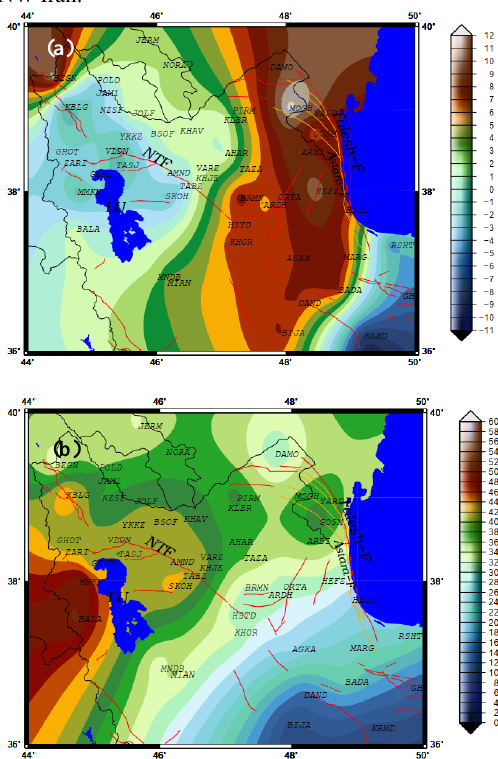
Figure 5. (a) surface dilatation rate. (b) Surface maximum-shear rates in the NW Iran (all values represented in part per billion per year).